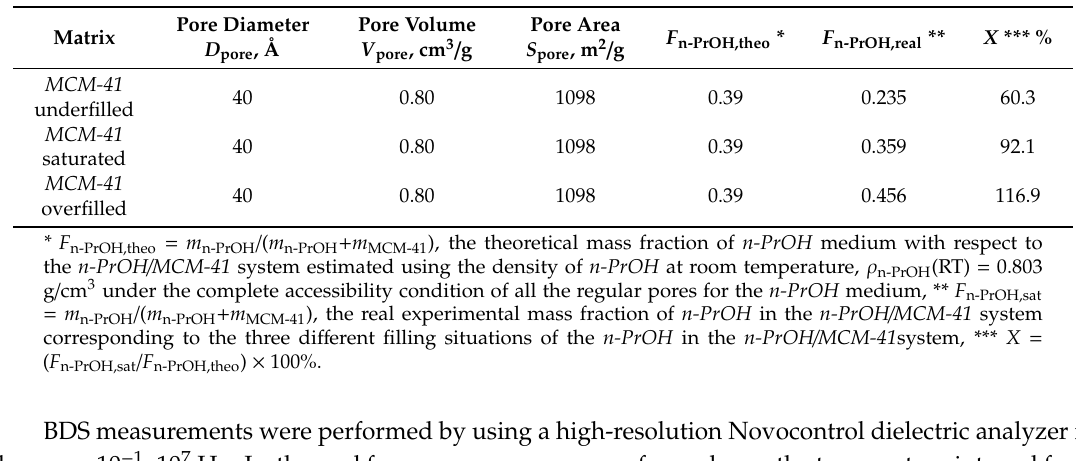
Table 1. Matrix and confined n-PrOH / MCM-41